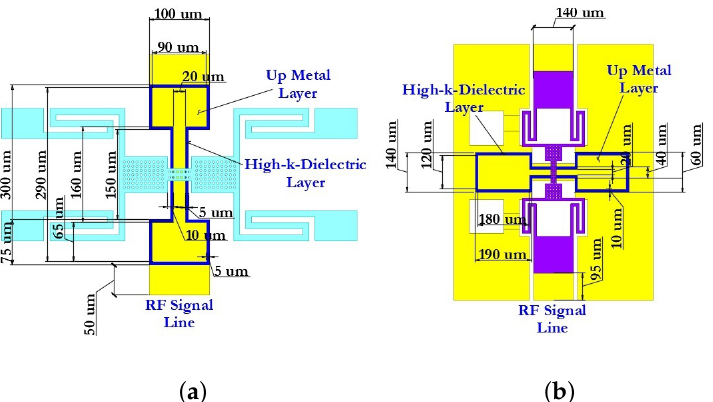
Figure 19. Schematic view of the developed additional fixed MIM capacitor: ( a ) switch (A); ( b ) switch